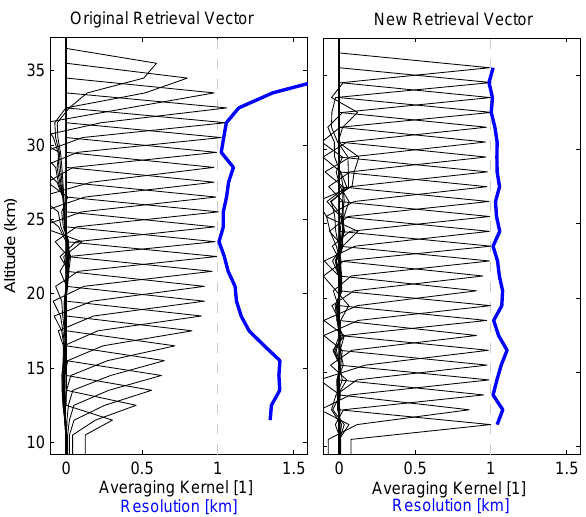
Fig. 2. The averaging kernel in black and resolution in terms of Full Width Half Maximum (FWHM) in blue for a simulated aerosol retrieval using lines-of-sight spaced 1km in tangent altitude. The left panel shows the result when using the retrieval vector defined in Eq. (1). The right panel shows the improvement when using the retrieval vector defined in Eq.